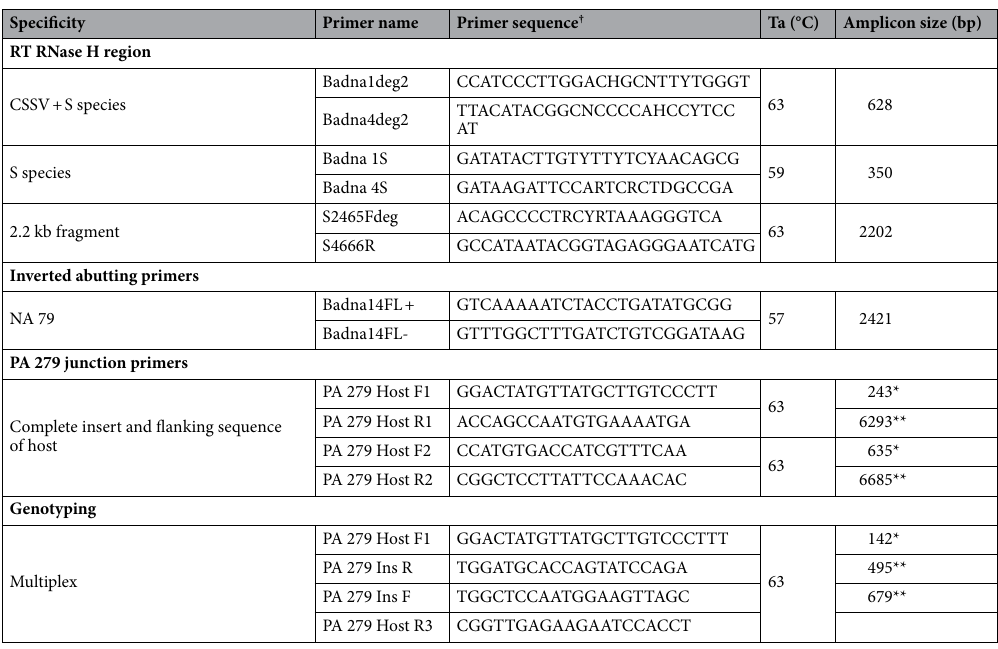
Table 2. PCR primers used in this study. † Letters in primer sequences refer to International Union of Pure and Applied Chemistry (IUPAC) codes for nucleotides. *expected size in cacao clone PA 279 without viral type VI insertion. **expected size in cacao clone PA 279 with viral type VI insertion.